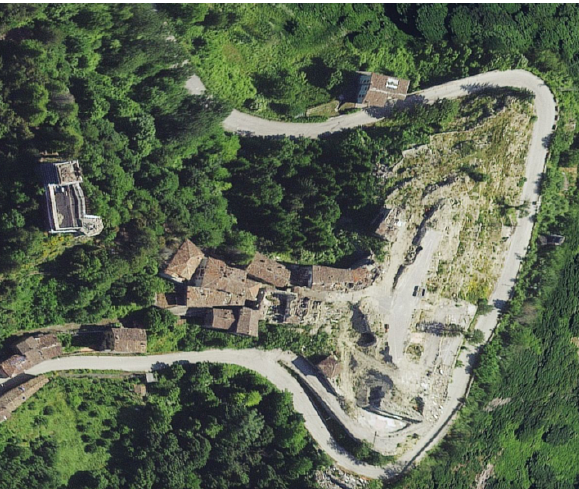
Figure 1. The stronghold standing on the hill surrounded by Borgo di Arquata (Google Maps)